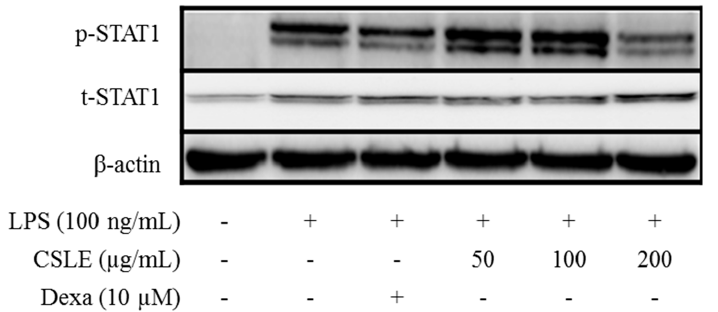
Figure 7. Effect of p-STAT1 expression by extract in LPS-stimulated RAW264.7 macrophages. Cells were pretreated with CSLE (0.05, 0.1, and 0.2 mg/mL) and dexamethasone (10 μ M) for 1 h before exposure to LPS (100 ng/mL) for 3 h. Cytosolic lysates were separated using SDS–PAGE. Total-STAT1, phospho-STAT1 and β -actin were detected using a western blot analysis.